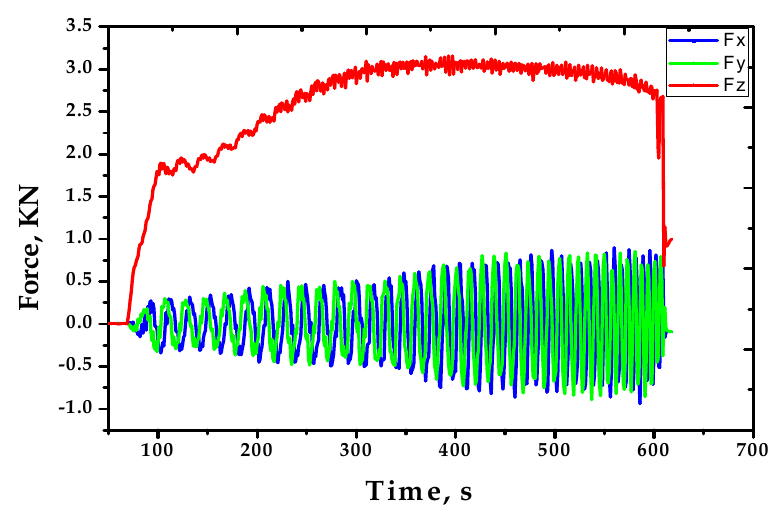
Figure 12. Forming forces in the three directions for the cone produced with run 3.